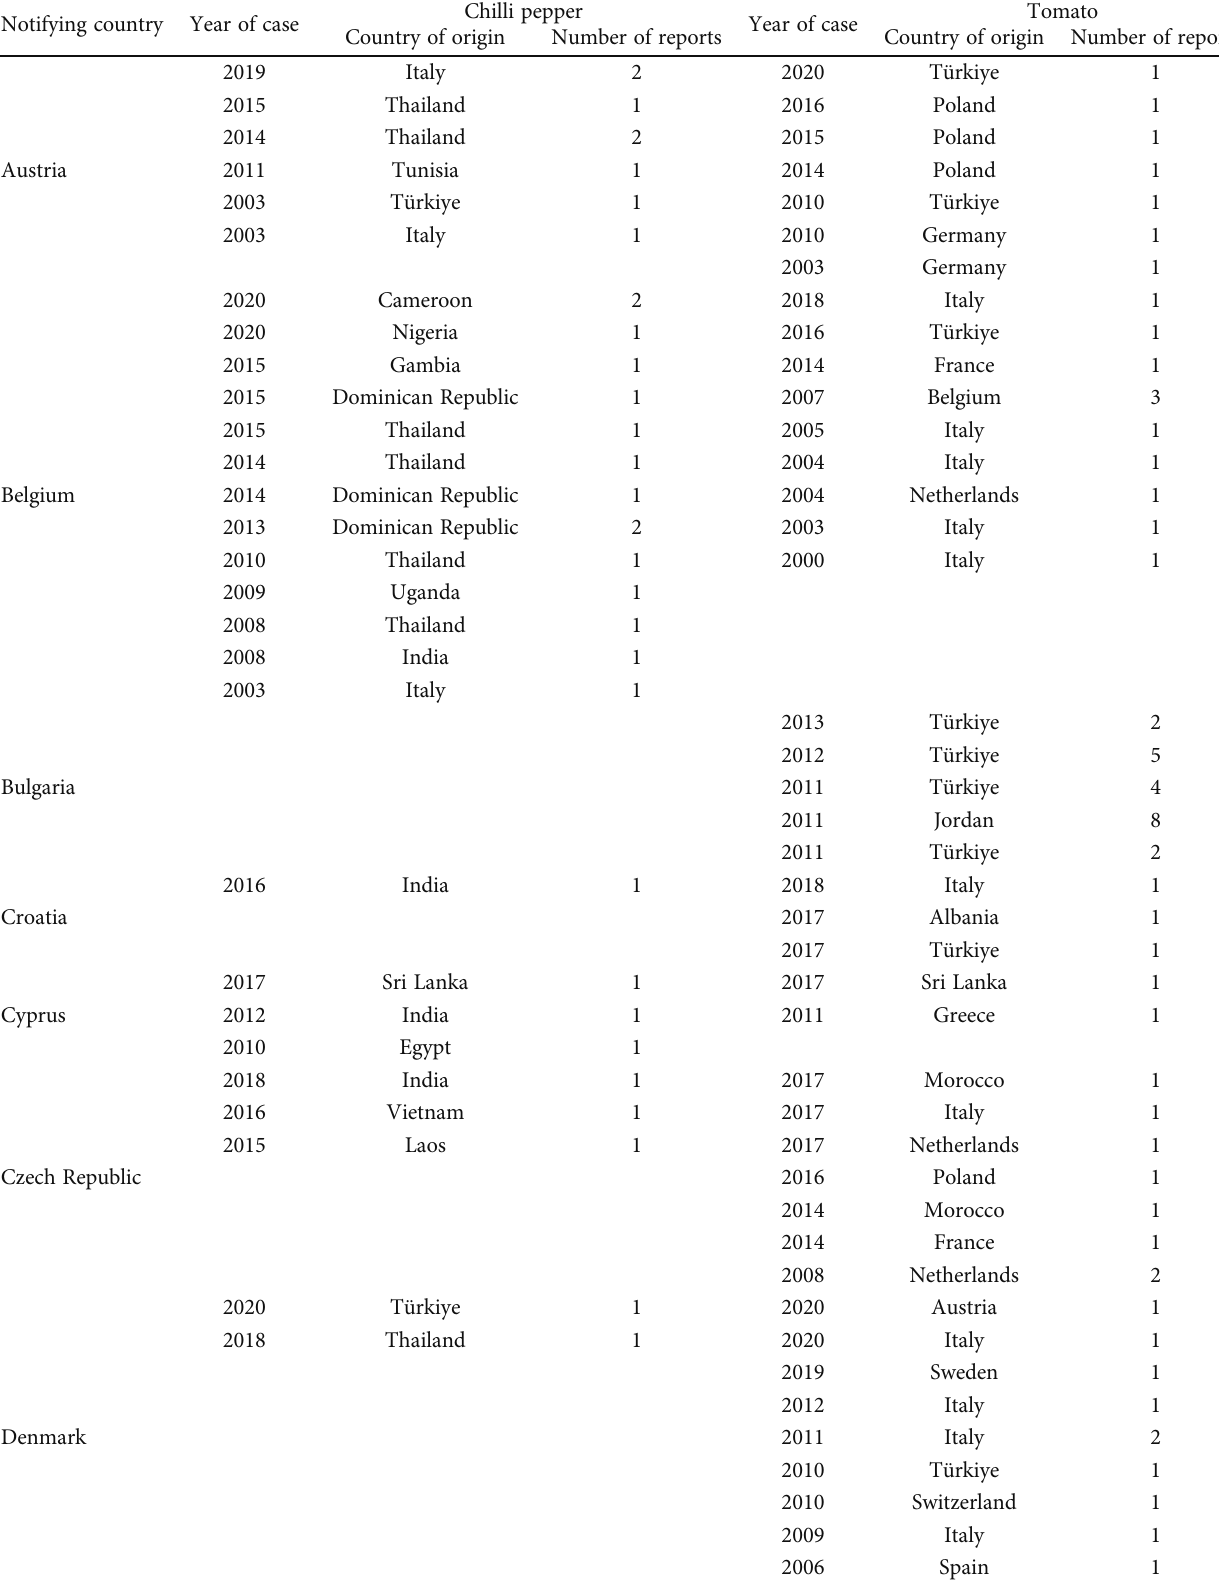
Table 1: RASFF data of adulteration reported in the chilli pepper and tomato supply chain by notifying country and country of origin. Notifying